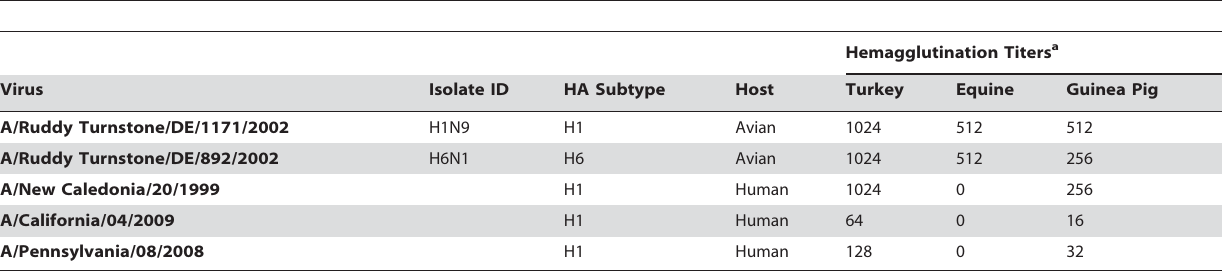
Table 4. Agglutination of erythrocytes from different animal species by human and avian influenza viruses.